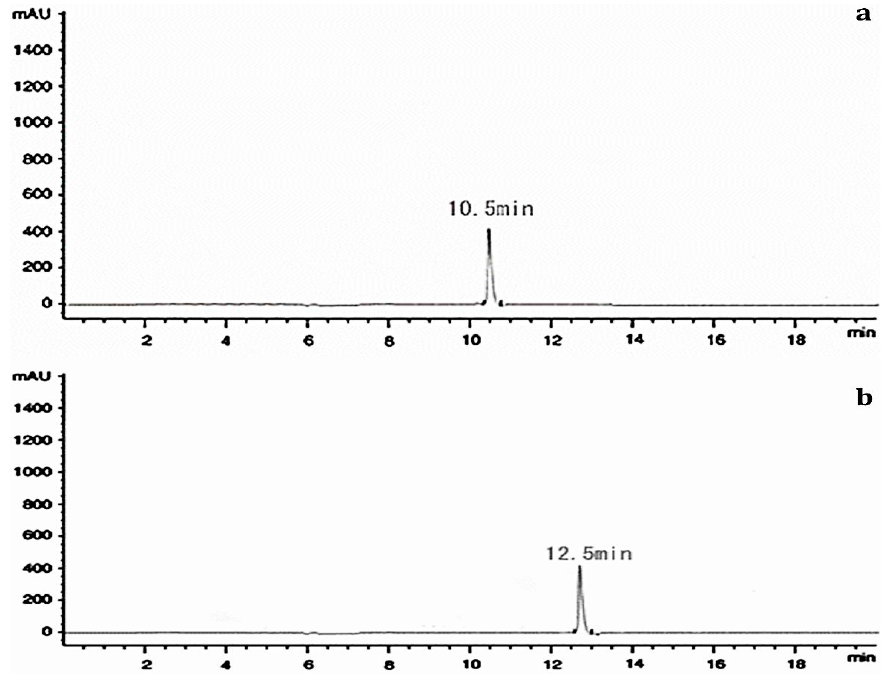
Figure 4. High-performance liquid chromatography (HPLC) chromatograms of Penicillium chrysogenum (CAL1) purified siderophore. ( a ) iron-free siderophore, ( b ) iron-containing siderophore.